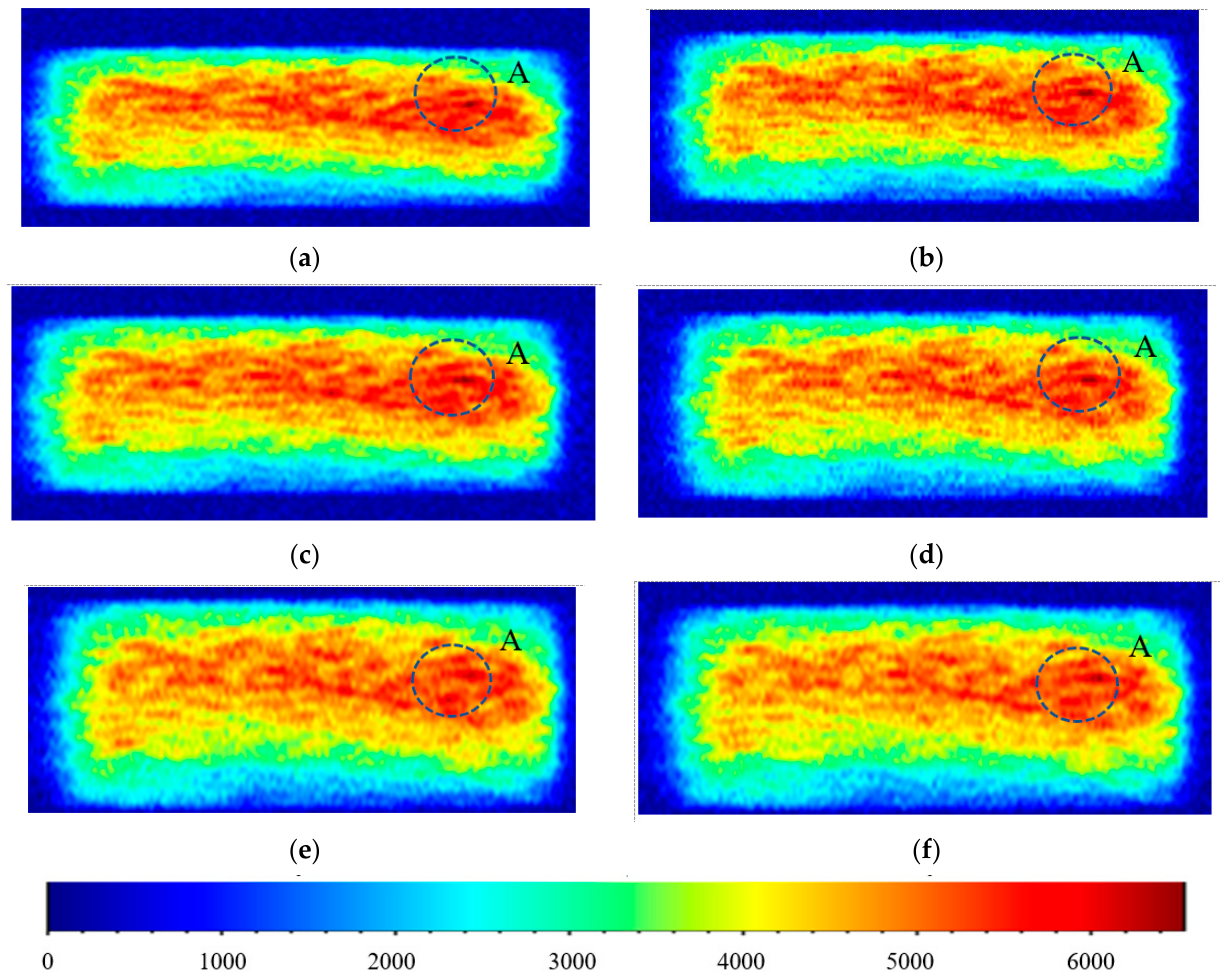
Figure 9. NMRI evolution of sandstone at the end of production after different cycles of fluid injection and production (A domain in the circle shows the obvious variation). ( a ) Cycle 1. ( b ) Cycle 10. ( c ) Cycle 20. ( d ) Cycle 30. ( e ) Cycle 40. ( f ) Cycle 50.